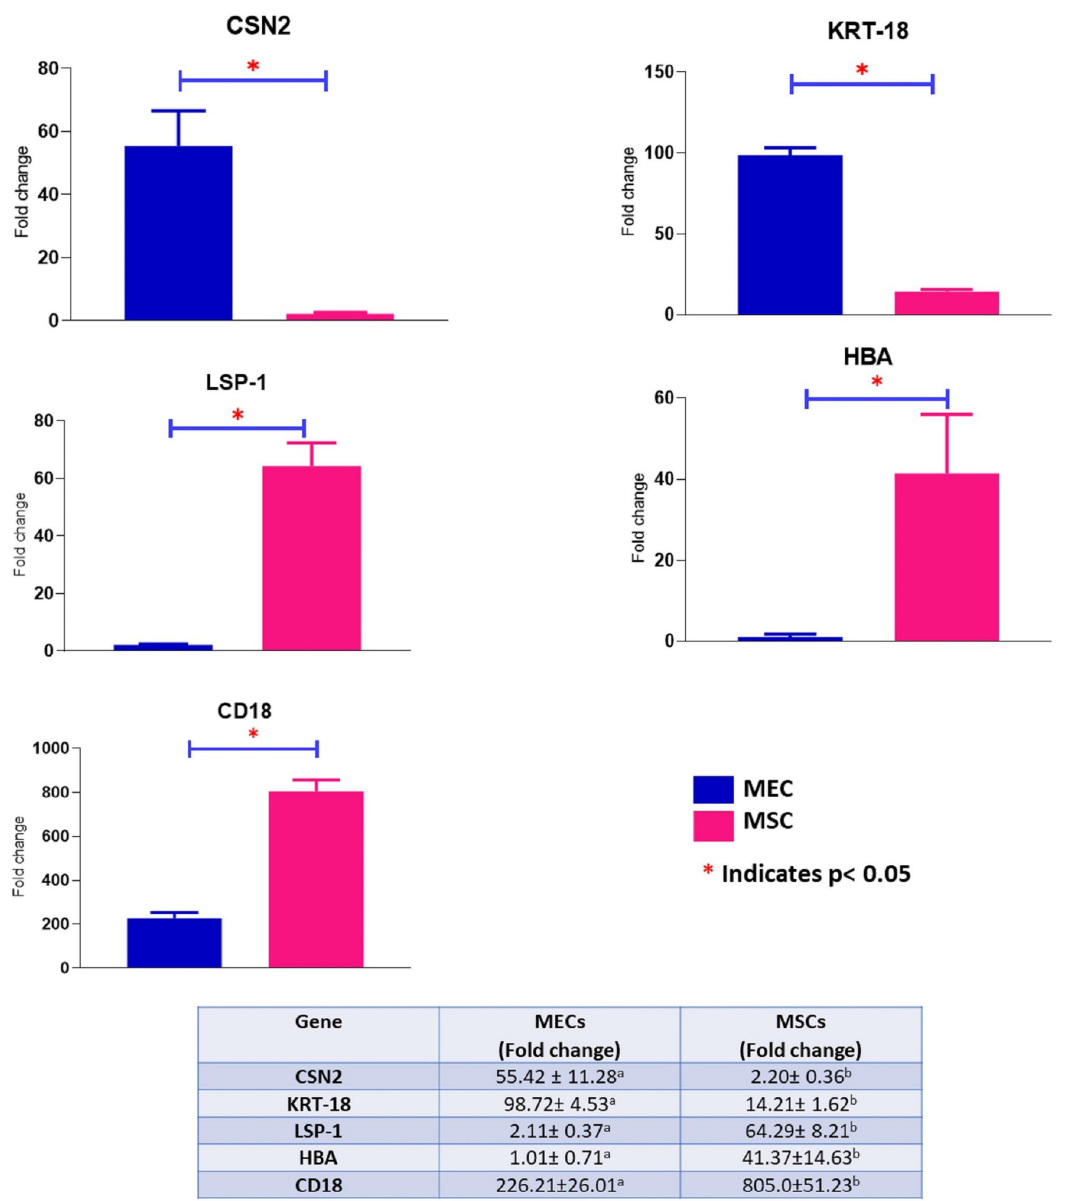
Fig 1. Comparison of the expression levels of different cell type marker genes in isolated mammary epithelial cells (MEC) as compared to milk somatic cells (MSC).